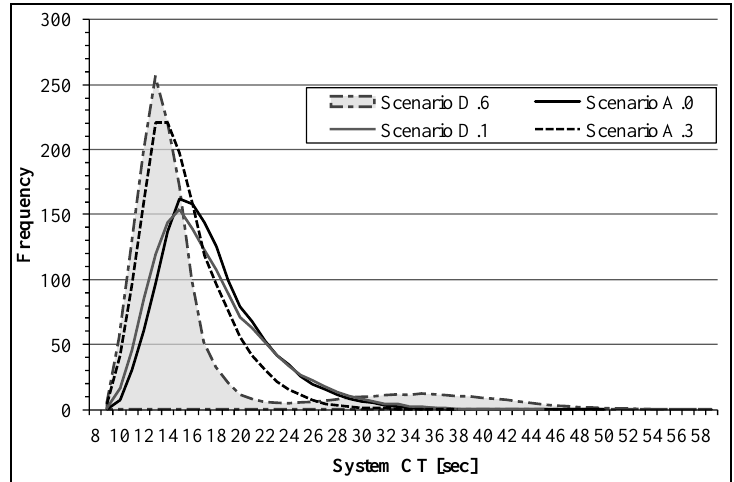
Figure 8. System output histograms for scenarios A.0, D.1, D.6 and A.3